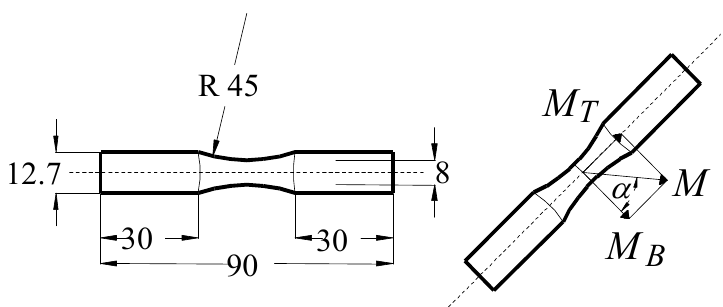
Figure 1: Fatigue tests on round specimens (10HNAP steel): torsion and bending.